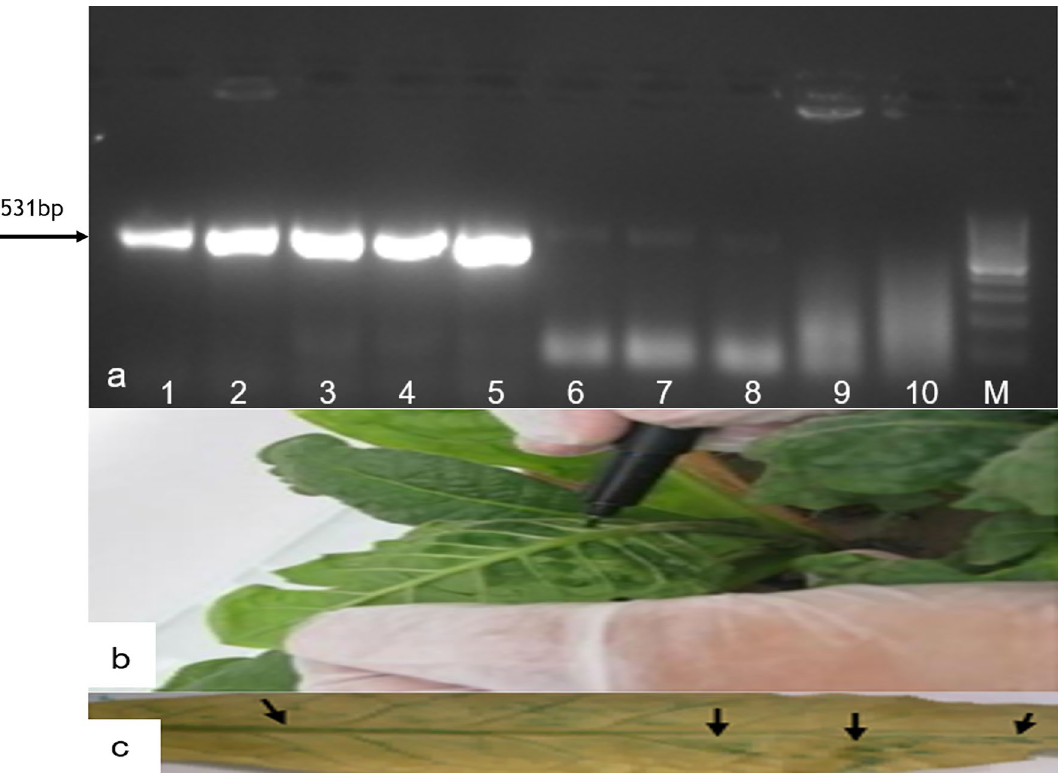
Figure 3. ( a ) Transformation of pGaZnF in Agrobacterium . ( a ) Colony PCR amplification of GaZnF gene, Lane M. 100 bp marker of Thermo Fisher Scientific Cat# SM1331, Lane 1. + ve control of pCAMBIA-1301 with GaZnF gene, Lane 2–8. plasmid of colonies of Agrobacterium cells containing GaZnF gene, Lane 9–10. − ve control PCR amplification of empty pCAMBIA-1301 . ( b,c ) Transient expression in Tobacco plants. ( b,c ) Agroinfiltration and histo-chemically GUS Assay in Tobacco species for transient expression of